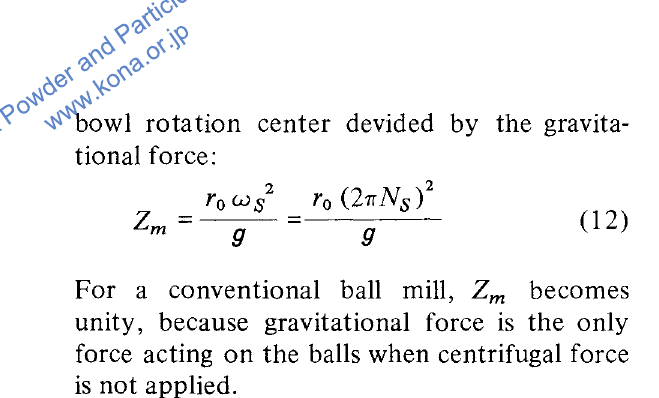
Fig. 1 0 Effect of centrifugal force on grinding rate shown by log-log expression in Fig. 10, where the values at Zm = 1 represent measured results obtained by the experiments under only gravi tational force. It is found from this figure that K could be related linearly to Zm in a log-log graph at the region of Zm > 4 where the effect of gravity would be negligible, compared with that of centrifugal force. That